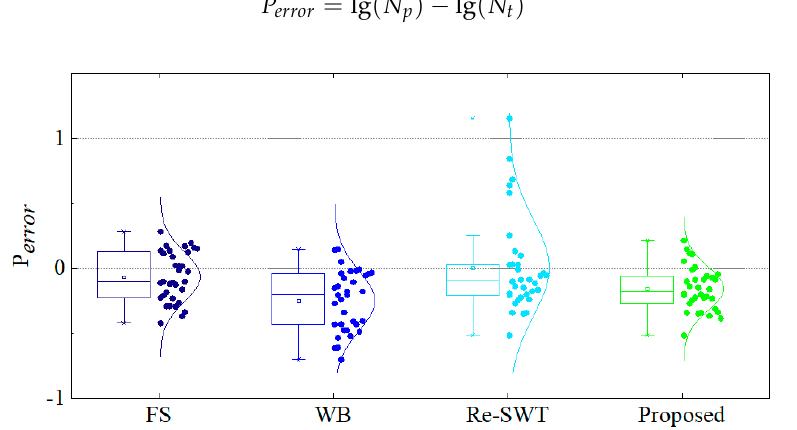
Figure 8. Estimation errors of GH4169 under symmetric loadings.